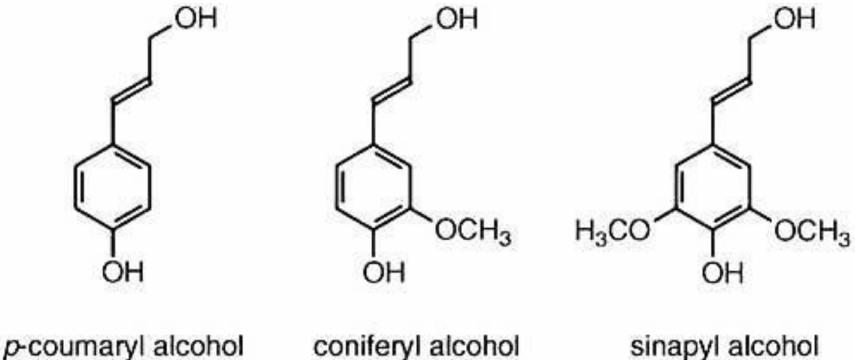
Figure 11. Phenolic alcohol precursors of plant lignin [2]. Reproduced with permission from ref. [2]. Copyright John Wiley and Sons,